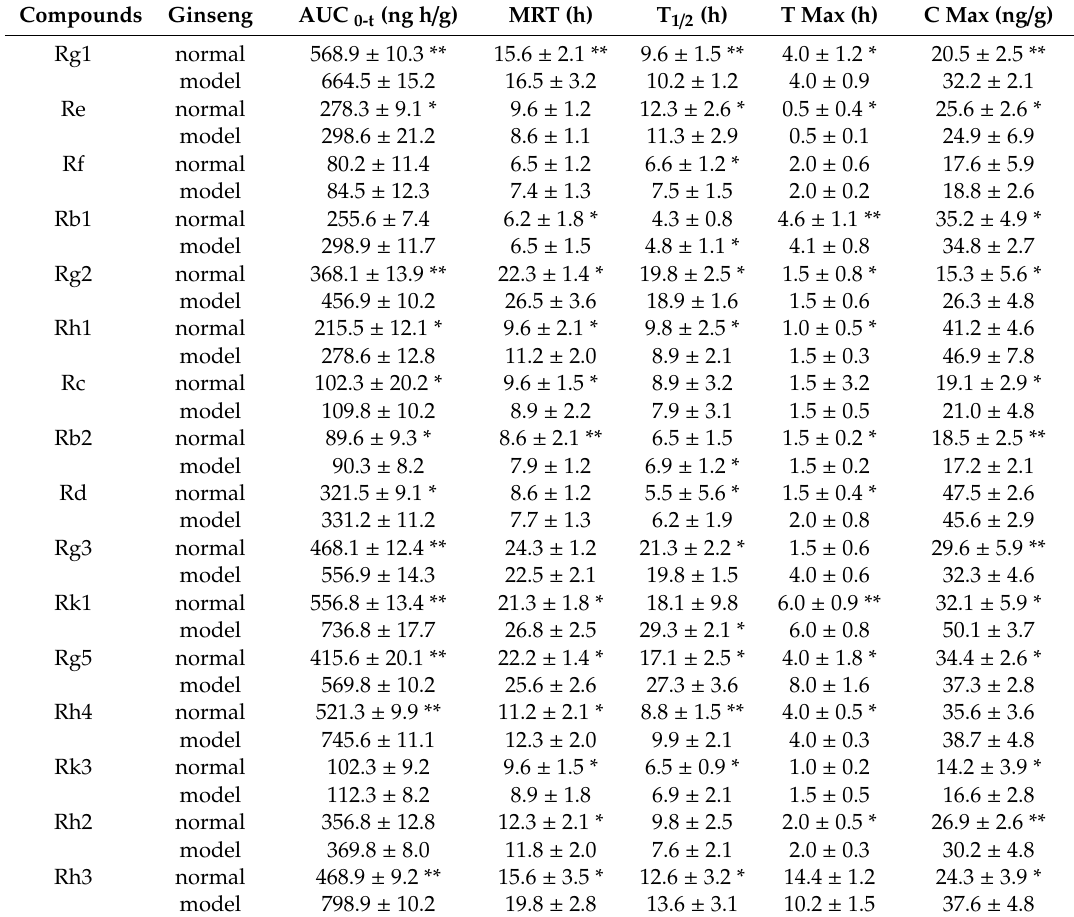
Table 2. Pharmacokinetic parameters of 16 ginsenosides in rat plasma following oral administration of RGS. All data are expressed as mean ± S.D. (n =